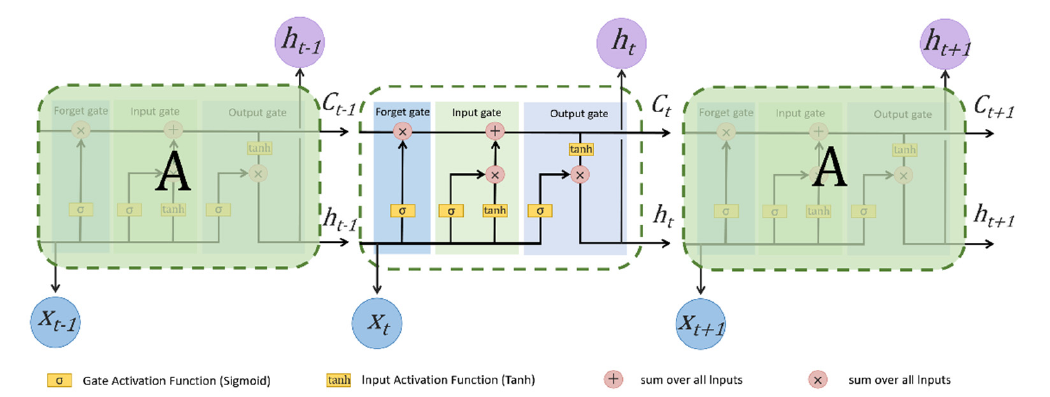
Figure 2. Structure of long short-term memory. h t , C t , and x t represent the output, cell state, and input at time t , respectively.